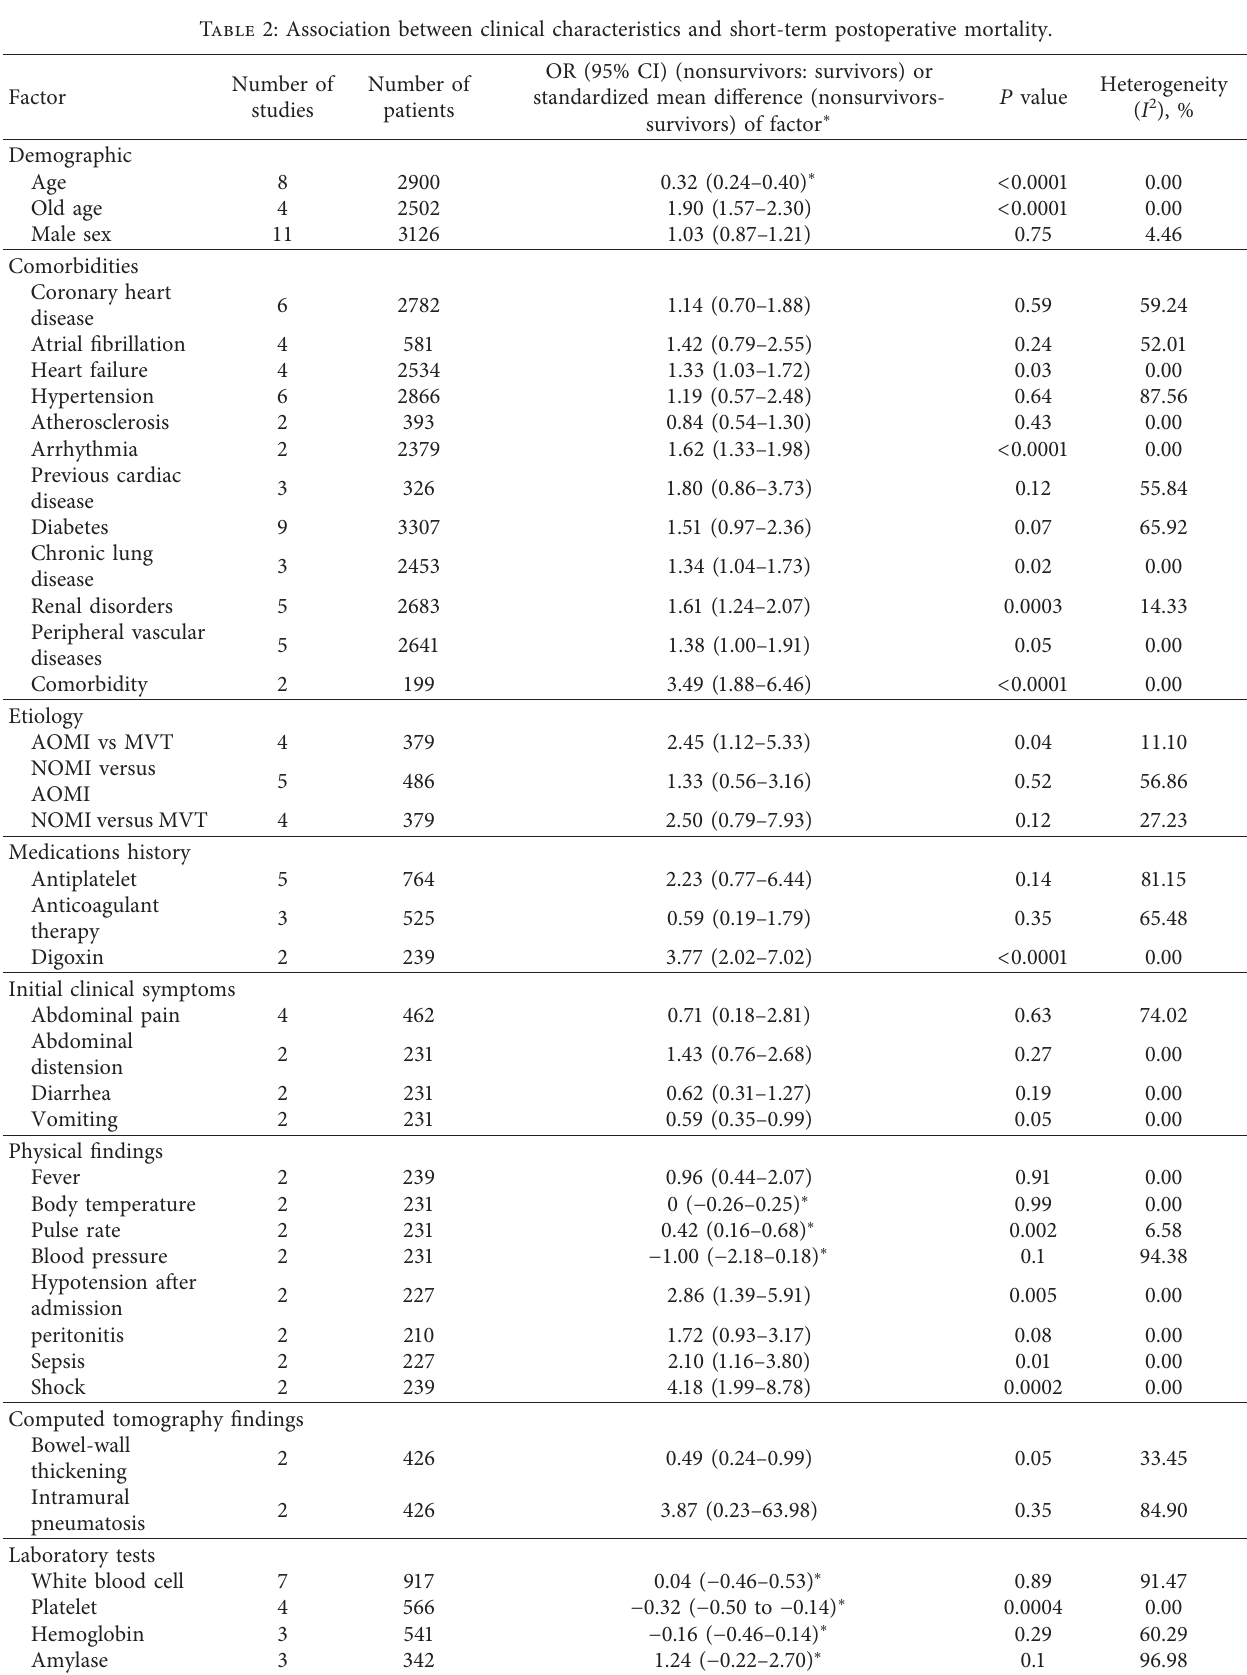
Table 2: Association between clinical characteristics and short-term postoperative